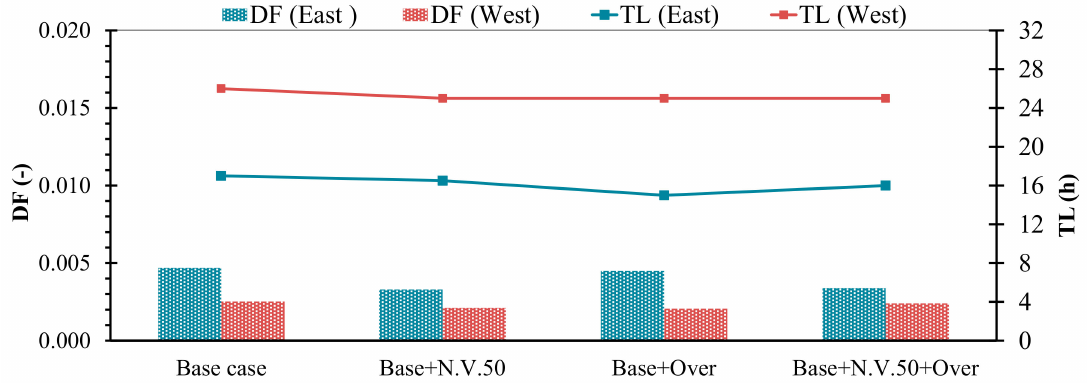
Figure 3. Decrement factor (DF) and time lag (TL) of east- and west-facing walls.